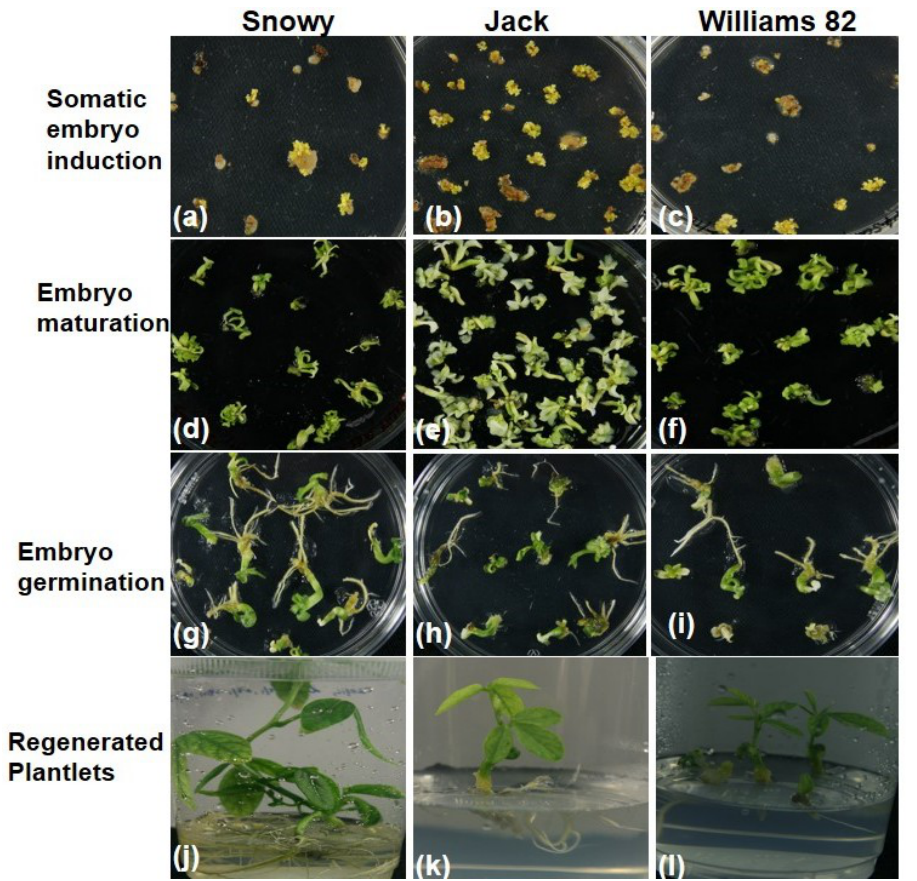
Figure 5. Comparison of cv. Snowy with Jack and Williams 82 for somatic embryogenesis, ( a – c ) induction, ( d – f ) maturation, ( g – i ) germination, and ( j – l ) regenerated soybean plants.